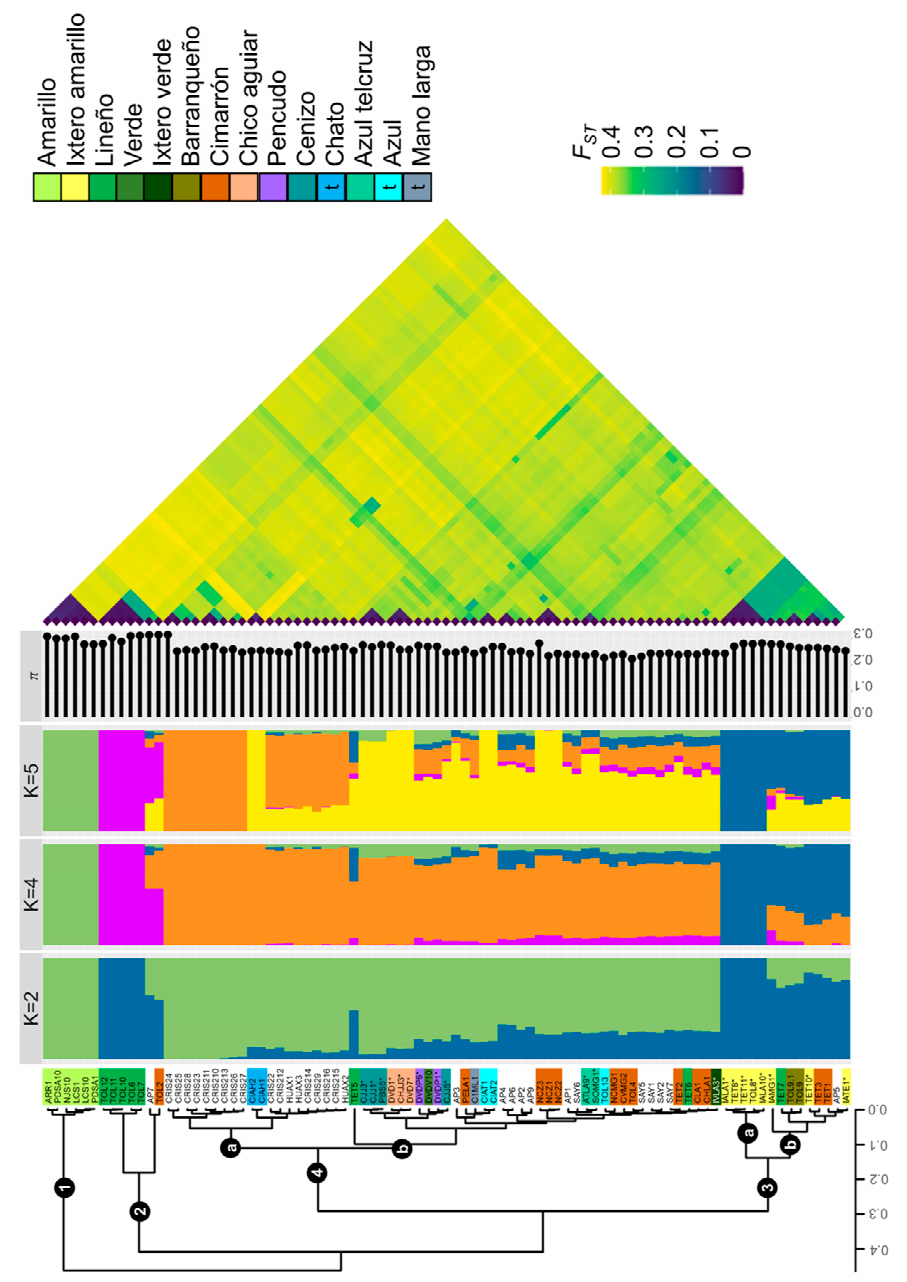
Figure 3. UPGMA, ADMIXTURE, π , and Fst analyses results. Landraces are color coded. t = A. te- quilana , * = A. rhodacantha or A. aff rhodacantha . The fourth cluster is the largest, comprising a cohesive group with highly related Table 1. Samples and information in this study. Municipality or Locality name where collected, samples, mostly coming from plants growing in the wild. This group comprises a more species name, landrace according to producer, code used in this study, voucher number if available, genetically diverse set of samples from different regions. It is split in two major subgroups: and number of accessions ( N 4a and 4b with excess of homozygotes and the highest values of Pi (Table 2). Cluster 4a includes all the wild plants sampled in San Cristobal de la Barranca (CRIS and HUAX coded samples), a region in the Northeast of Jalisco, geographically close to Tequila, the